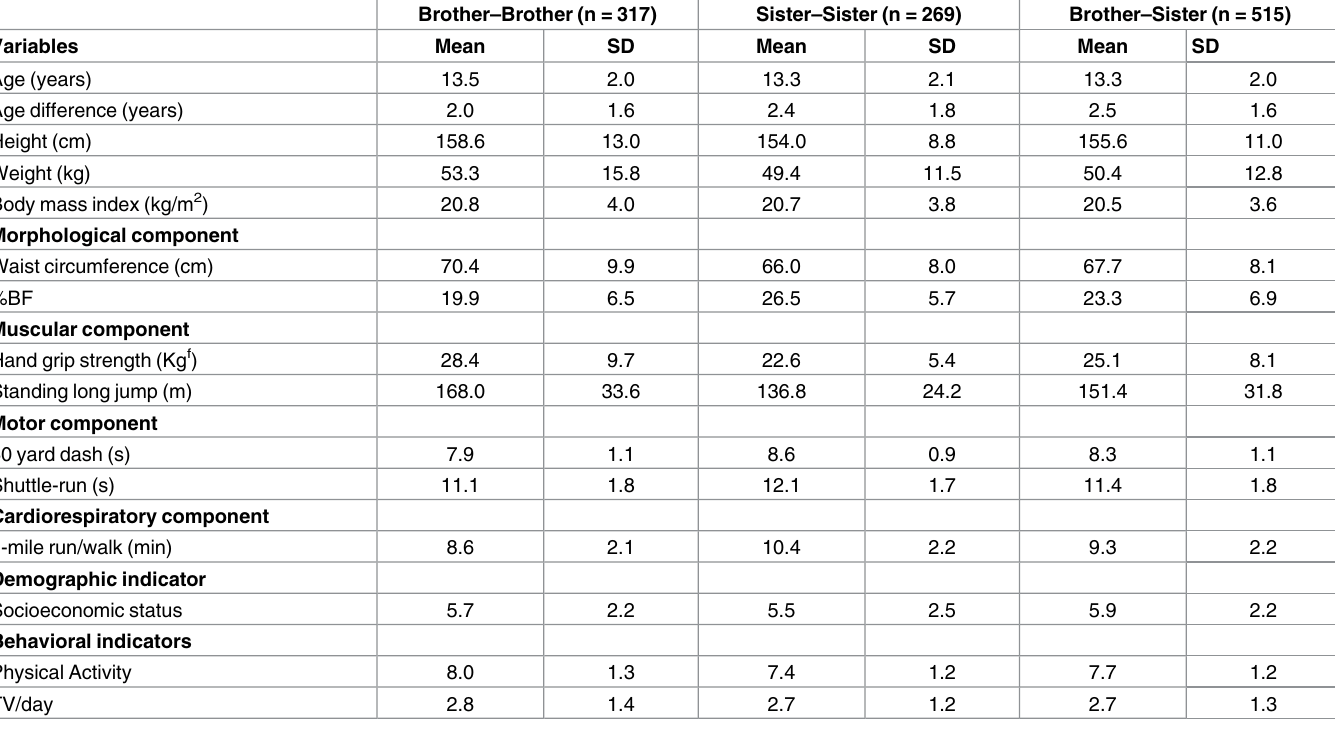
Table 1. Descriptivestatistics (means and standard deviations (SD)) for siblings